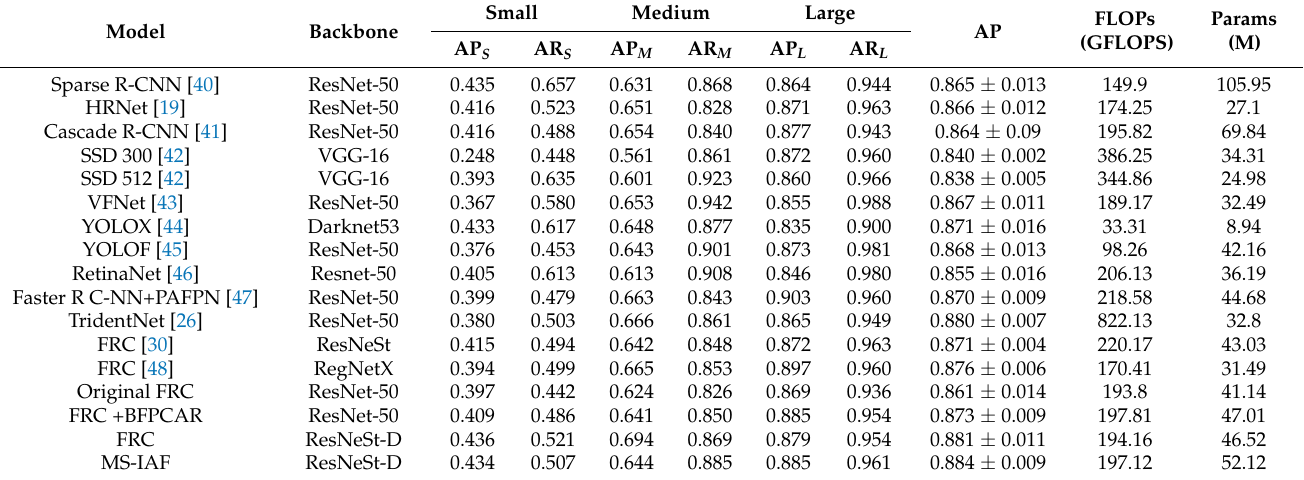
Table 2. Experiment results (Comparative experiments of AP-DATA under different